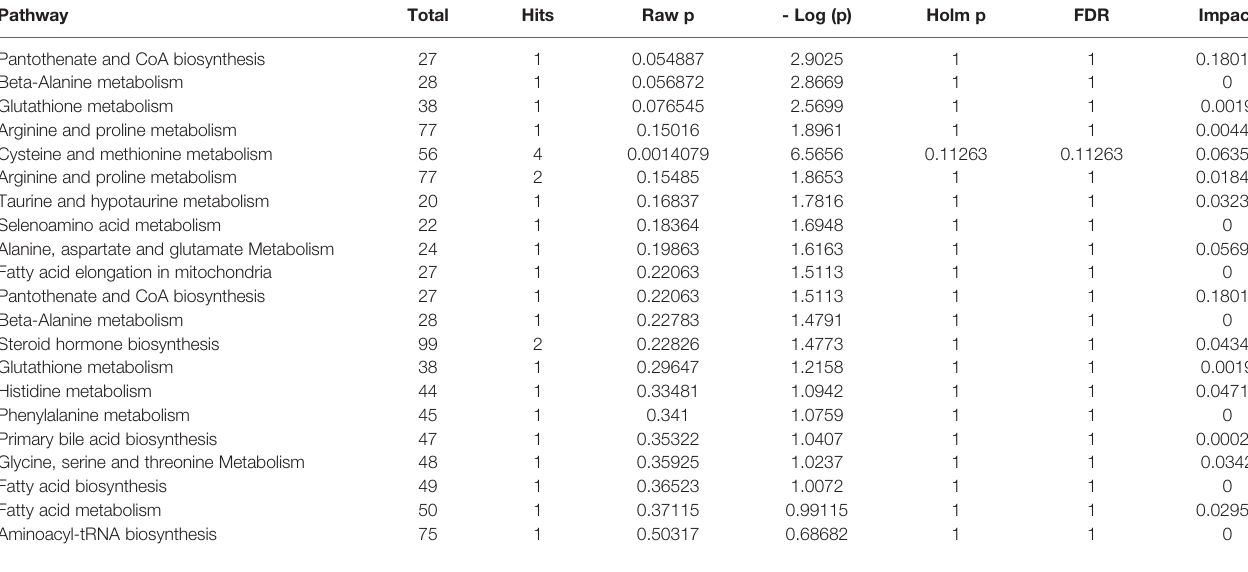
TABLE 1 | Signi fi cantly differential metabolic pathways between insomnia disorder patients and healthy controls. Pathway Total Hits Raw p - Log (p)